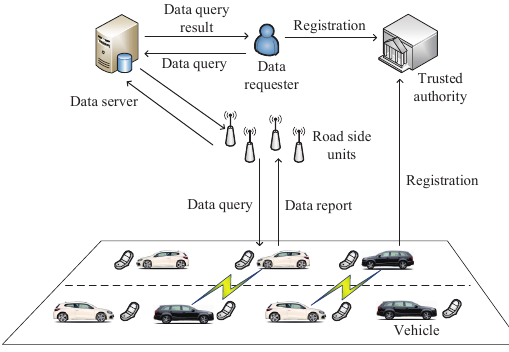
Figure 13. The architecture of the secure range query